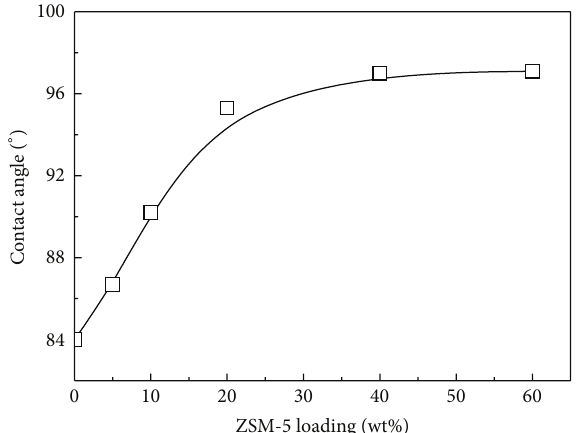
Figure 5: Effect of ZSM-5 loading on the contact angle of PEBA/ZSM-5 membranes.